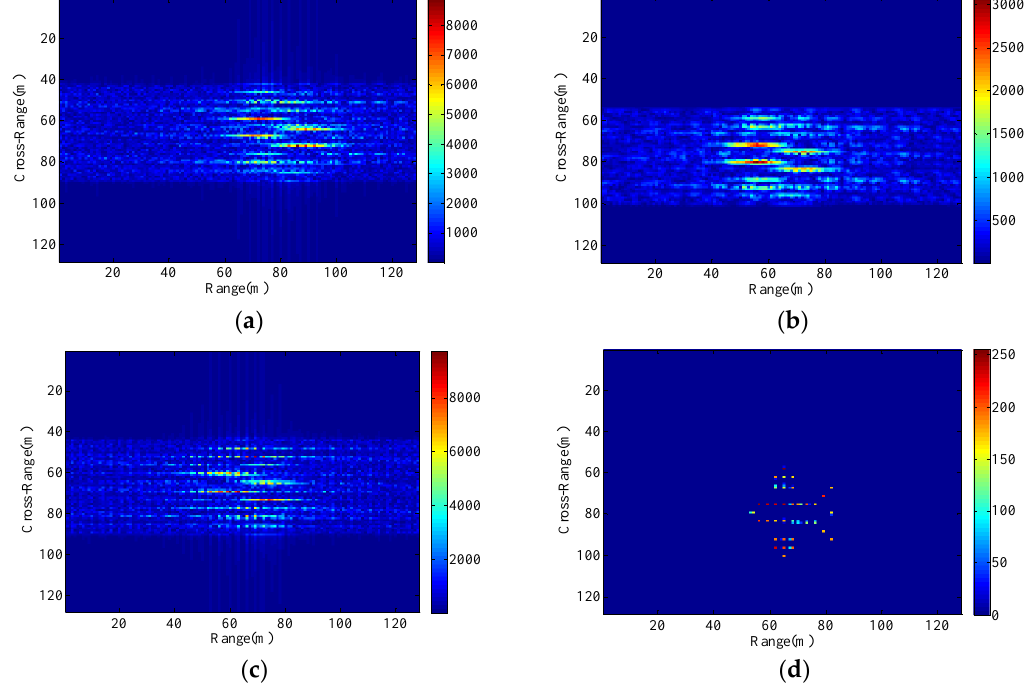
Figure 11. Imaging results with the radar platform vibration parameters P6. ( a ) RD algorithm; ( b ) cross-correlation method; ( c ) minimum entropy method; ( d ) the proposed method.